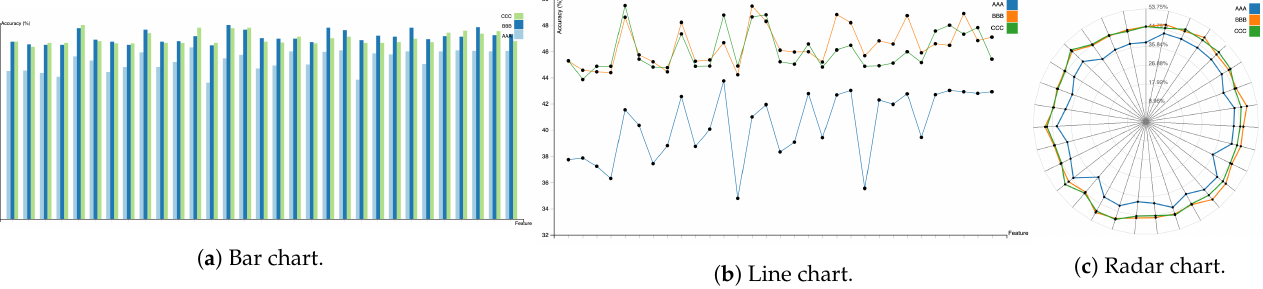
Figure 8. Comparison of three ML algorithms for the same data set with three visualisation